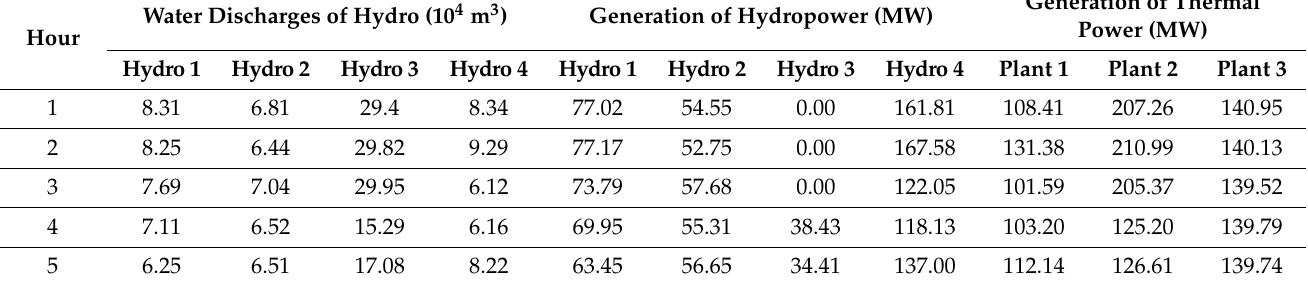
Figure 4. Storage volume of reservoir with NSDOGSA for MSHTS of Test System-I. Table 5. Schedule results for the MSHTS of Test System-I should be compromised with Table 4. N on-dominated solutions for MSHTS of Test System-I achieved using various methods.